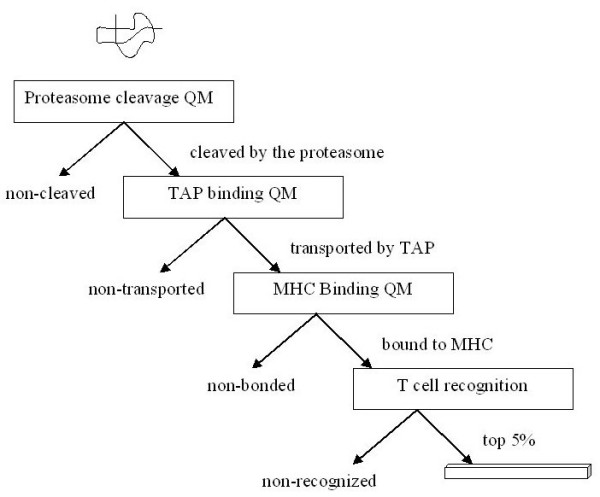
Flowchart of EpiJen.